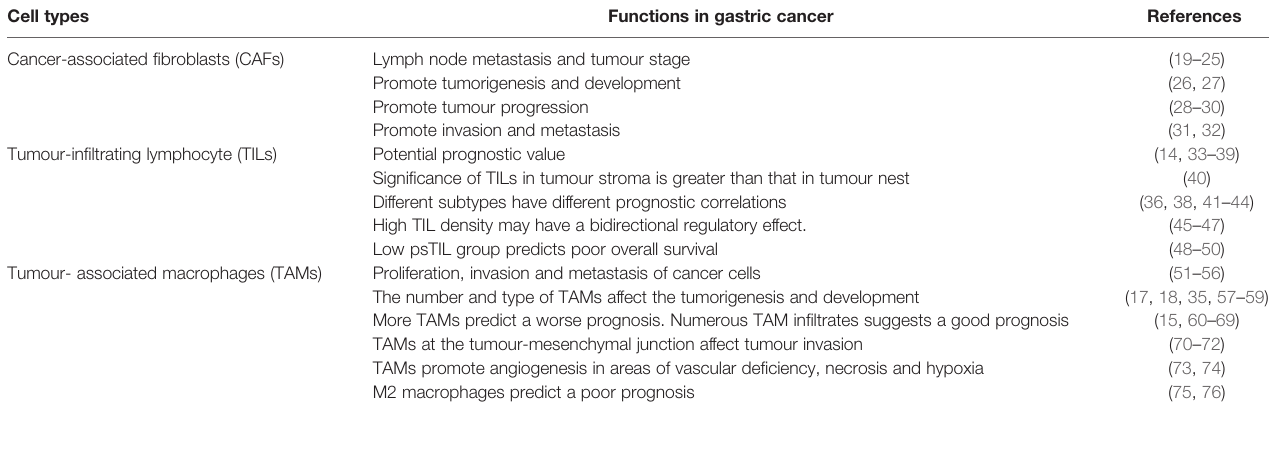
TABLE 1 | Functions of different cell types in gastric